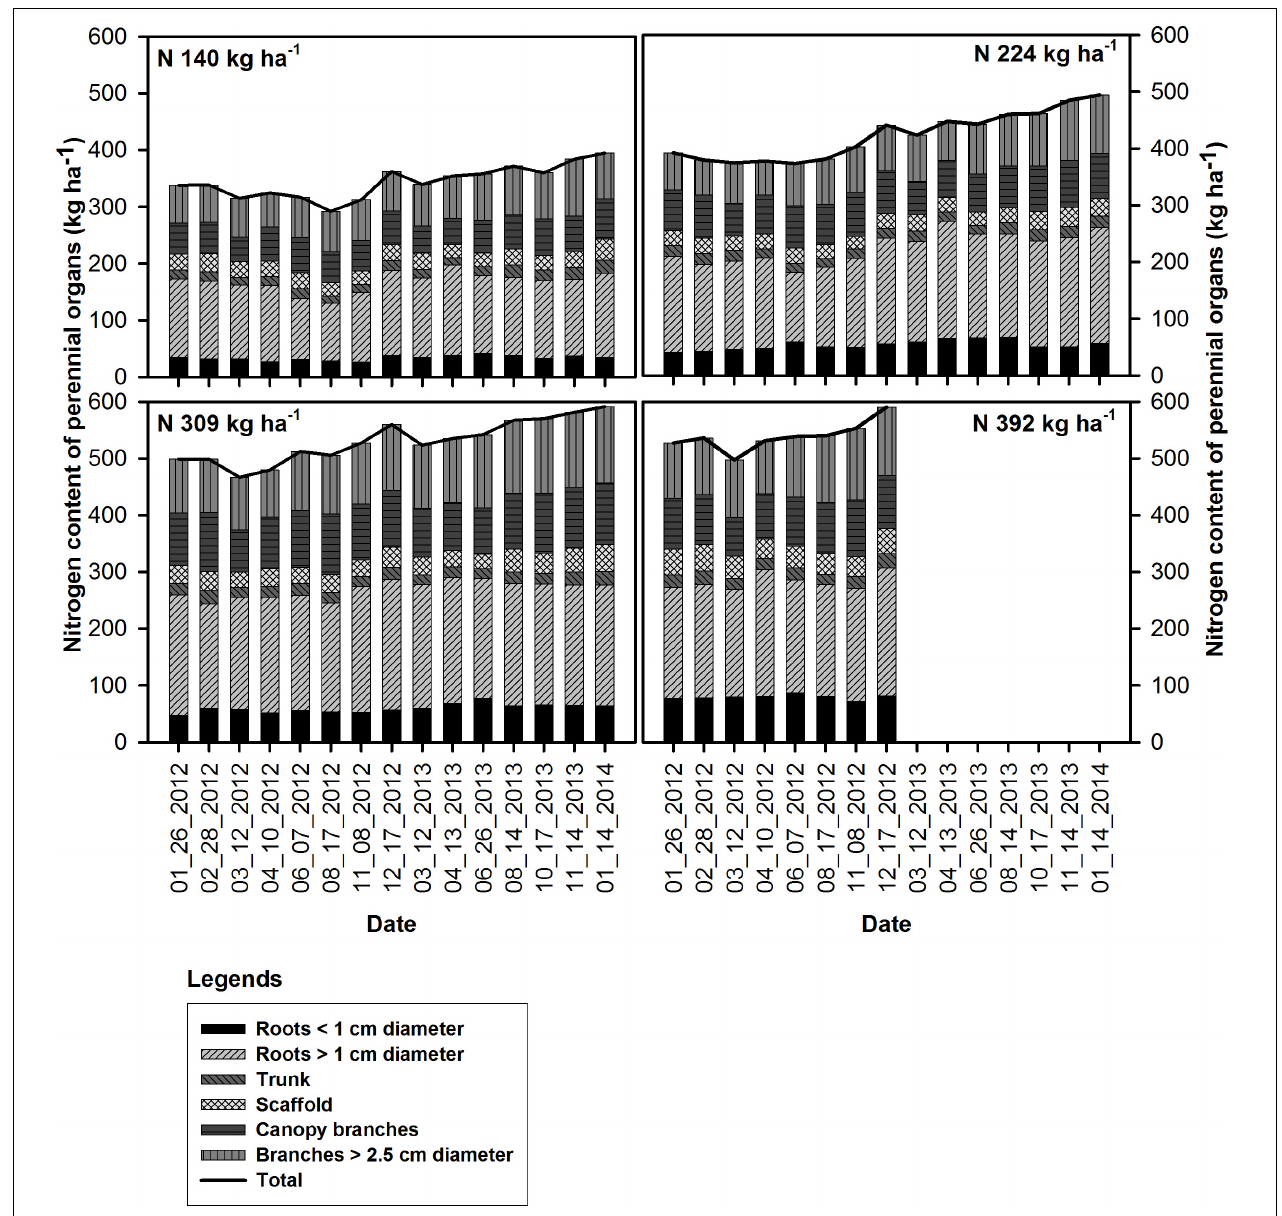
FIGURE 1 | Seasonal changes in the nitrogen content of the perennial organs and mean total tree N content (kg ha − 1 ) under N rate treatments in 2012 and 2013.